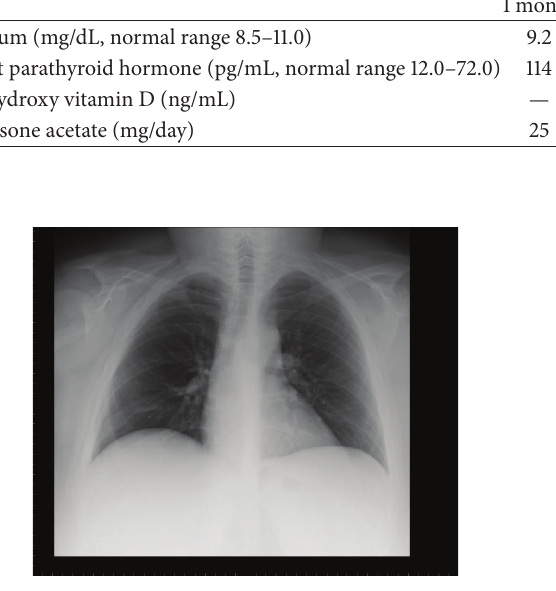
Calcium (mg/dL, normal range 8.5–11.0)